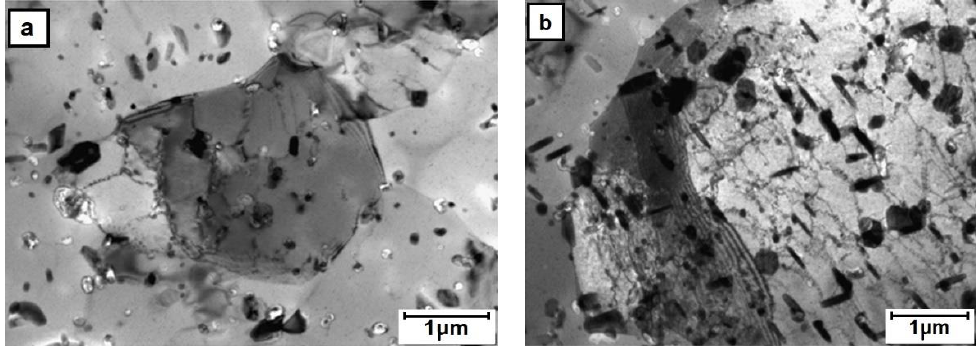
Figure 8. TEM microstructure of the core area (E/224 rpm) presenting: ( a ) fine and ( b ) coarse grain areas.